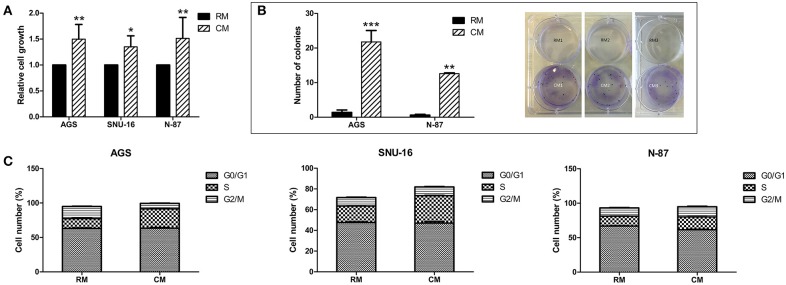
Omental tissue CM enhances gastric cancer cell growth. (A) XTT assay showing significant increased proliferation (P < 0.05) of gastric cancer cells co-cultured with omental tissue CM; n = 4 (B) Omental tissue CM enhanced gastric cancer cell clonogenicity (P < 0.01). Left panel graphs represent the average of five repeated experiments ± SD, Right panel depicts representative images of AGS (left and middle rows) and N-87 (right row) colonies; n = 5 (C) Omental tissue CM enhanced S-phase population in gastric cancer cells; a more prominent effect was seen in AGS and SNU-16 (P < 0.05) cells than in N-87 cells; n = 6. *P < 0.05; **P < 0.01; ***P < 0.001.